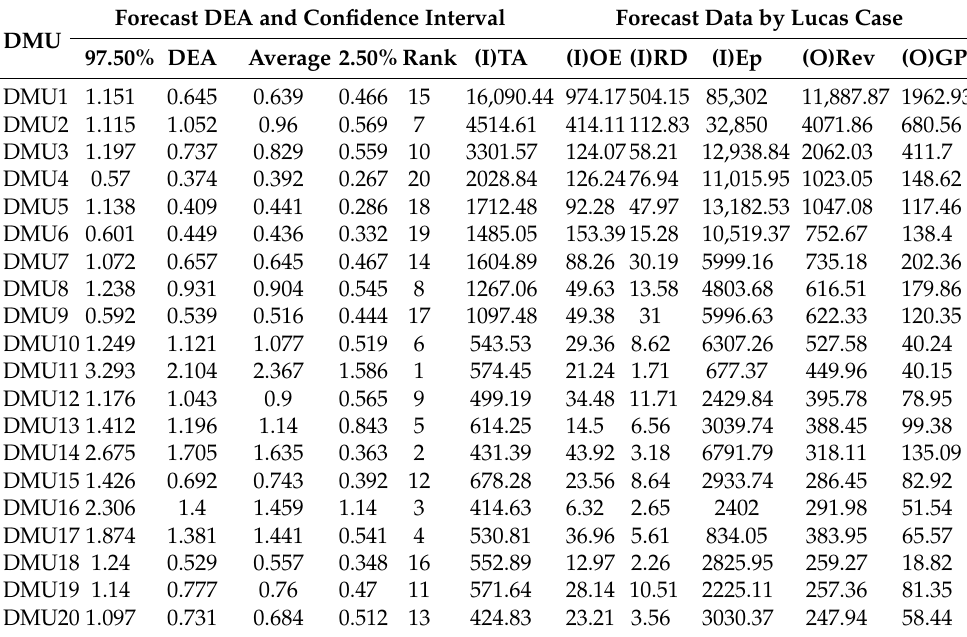
Table 6. 2020 forecast data by Lucas, data envelopment analysis (DEA) score, and ranking.